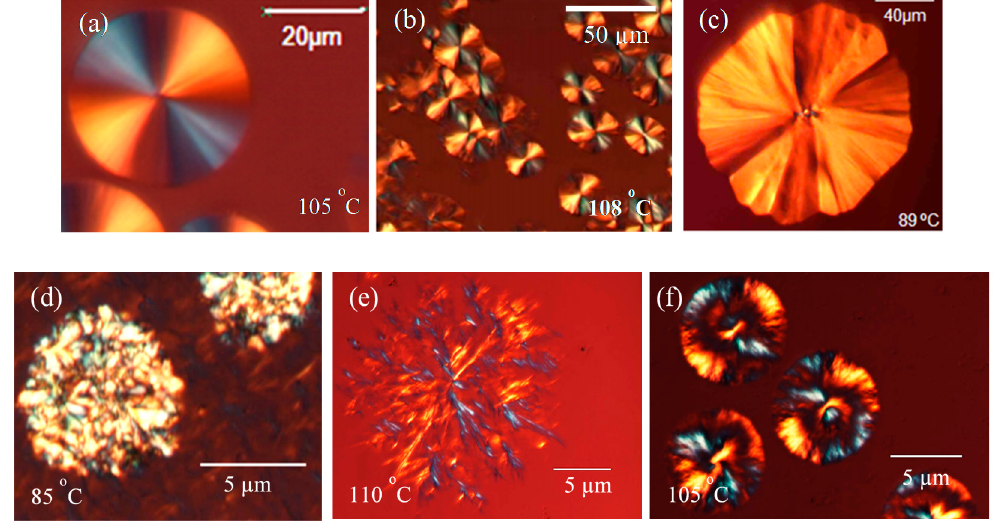
Figure 2. PLOM micrographs for ( a ) DL 1006.1 ; ( b ) LL 1005.4 ; ( c ) BS 1007.4 ; ( d ) LL 705.4 - mb -BS 307.4 ; ( e ) LL 205.4 - mb -BS 807.4 ; and ( f ) DL 206.1 - mb -BS 807.4 , during isothermal crystallization at the indicated T c .